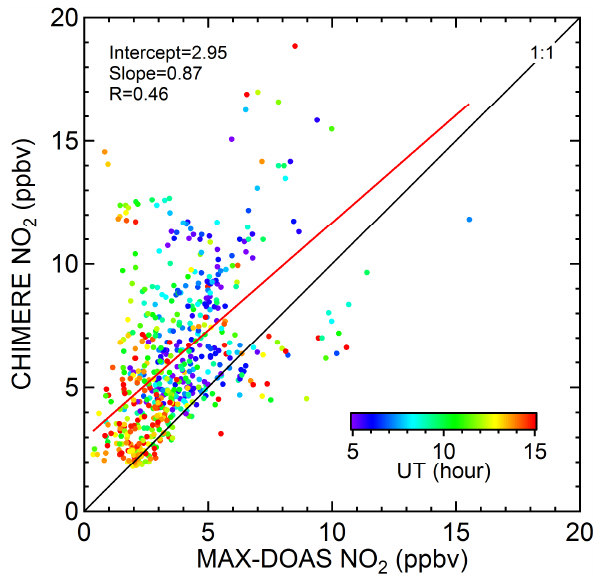
Fig. 9. Correlations between NO 2 VMRs from MAX-DOAS and CHIMERE. Colors represent the time of day in UT hour. The linear least-squares fit taking into account error ranges of MAX-DOAS data is shown with the red line. The correlation coefficient R is given in the plot.